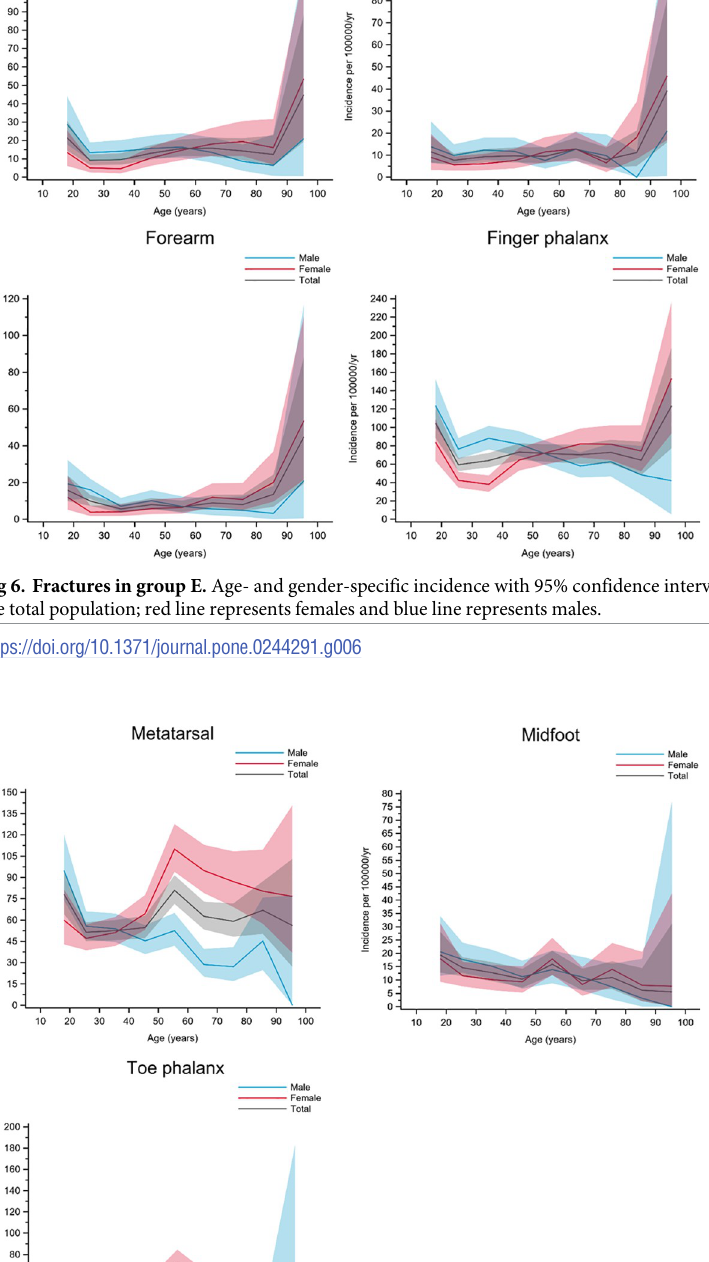
PLOS ONE | https://doi.org/10.1371/journal.pone.0244291 December21,